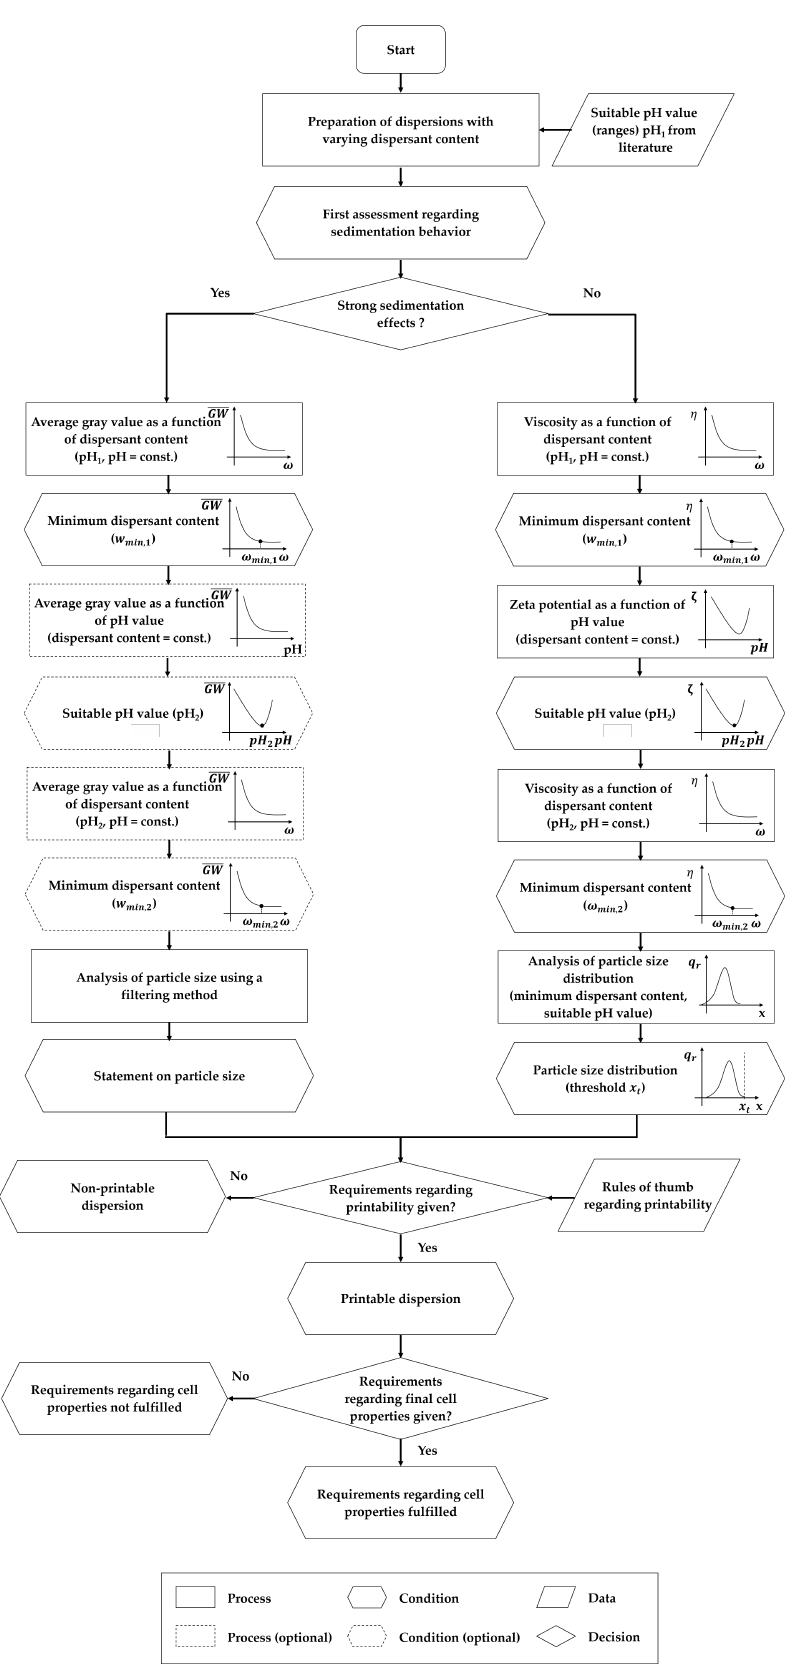
Figure 12. Flow chart showing the methodology; the symbols of the illustration were selected according to DIN 66001